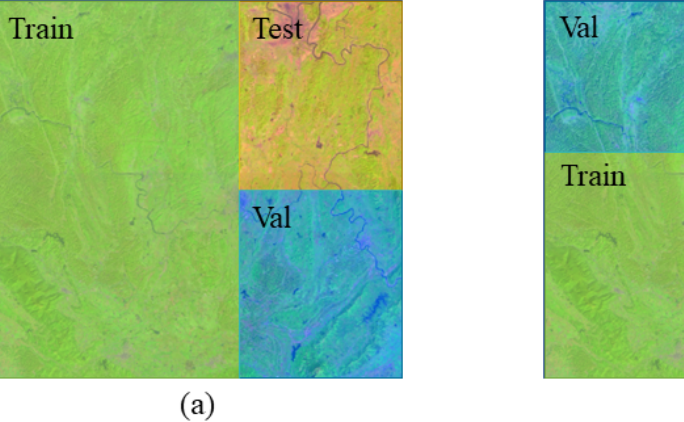
Figure 2. Dataset partitioning: ( a ) dataset I and ( b ) dataset II.